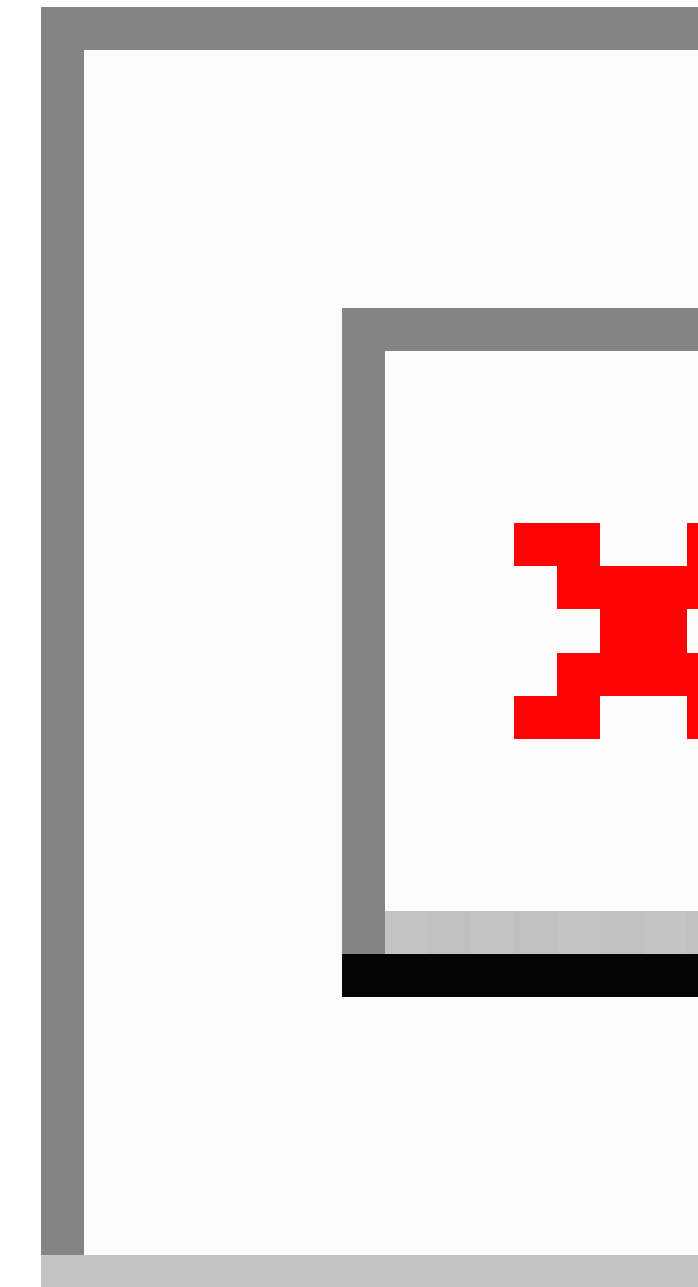
Figure 1. Steps required to input and create an automatic educational text